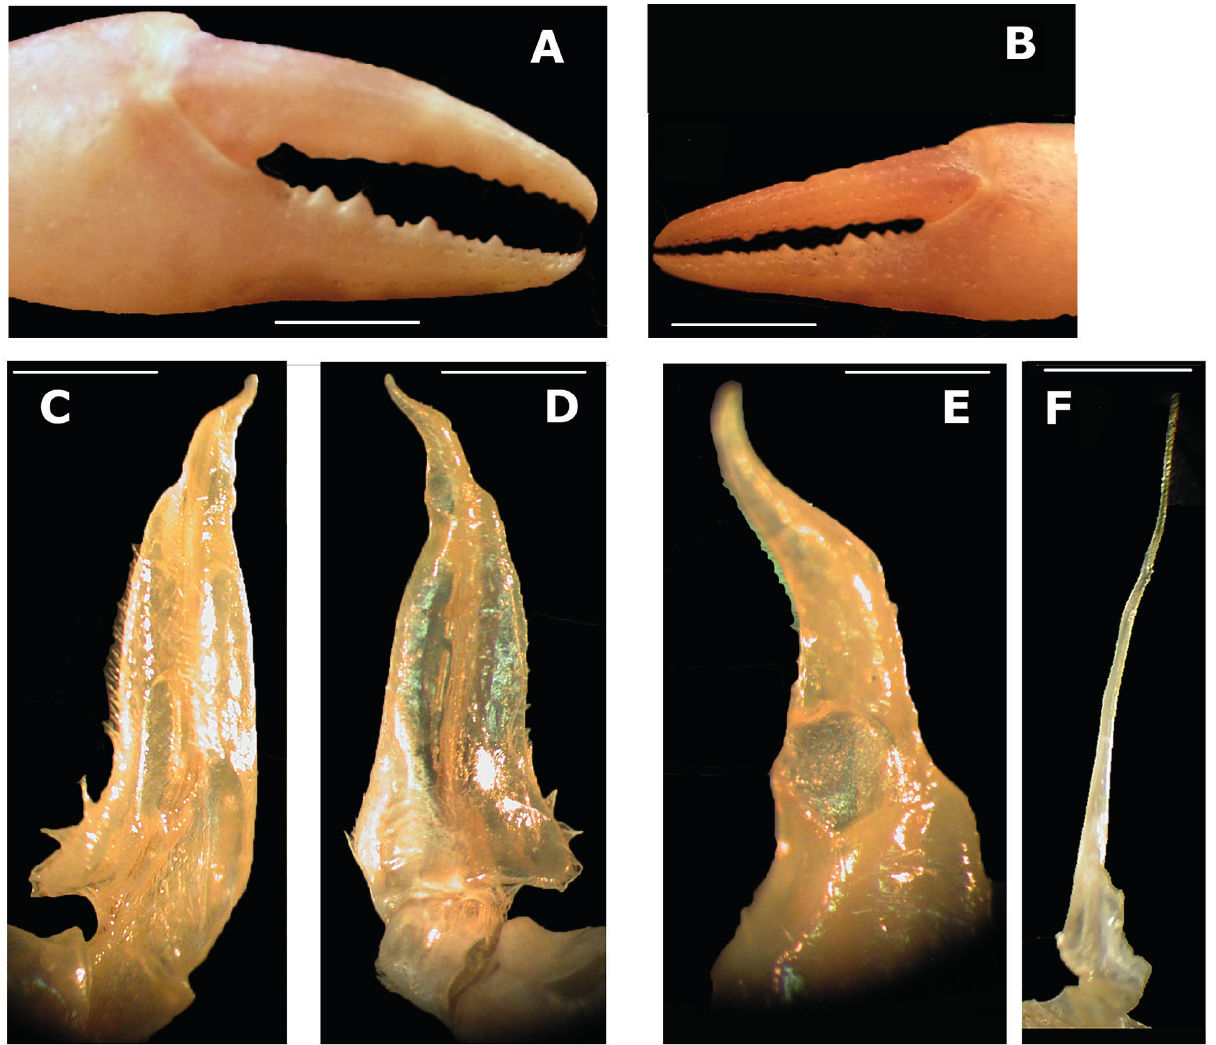
Figure 2. Potamonautes gorongosa, new species, male holotype (CW 25.4 mm) from Gorongosa National Park, Sofala Province, Mozambique (NMU PN 2014). A, major cheliped; B, minor cheliped; C, right GO1, ventral view; D, right GO1, dorsal view; E, right GO1, dorsal view showing detail of terminal article; F, right GO1, ventral view. Scale bar = 2.5 mm, A, B; 6.25 mm,